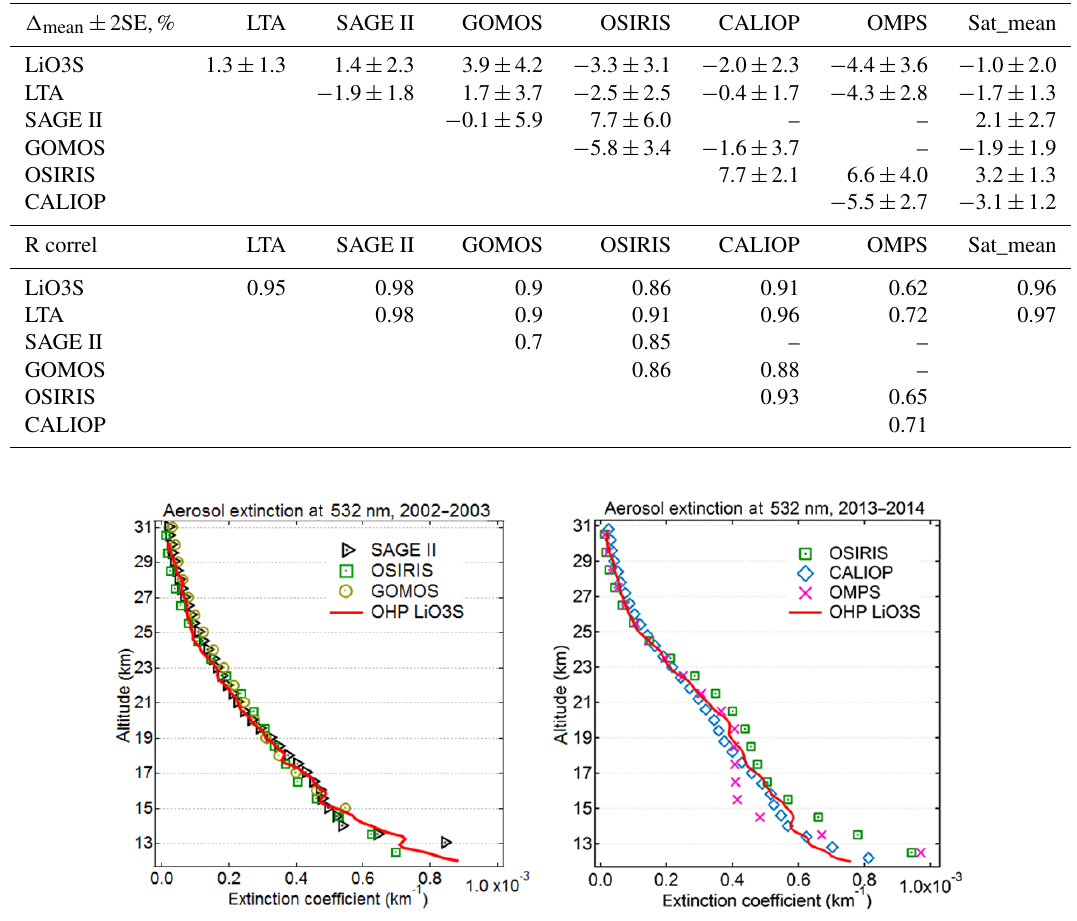
Figure 2. Comparison of aerosol extinction profiles at 532nm from OHP lidars and satellites averaged over volcanically quiescent